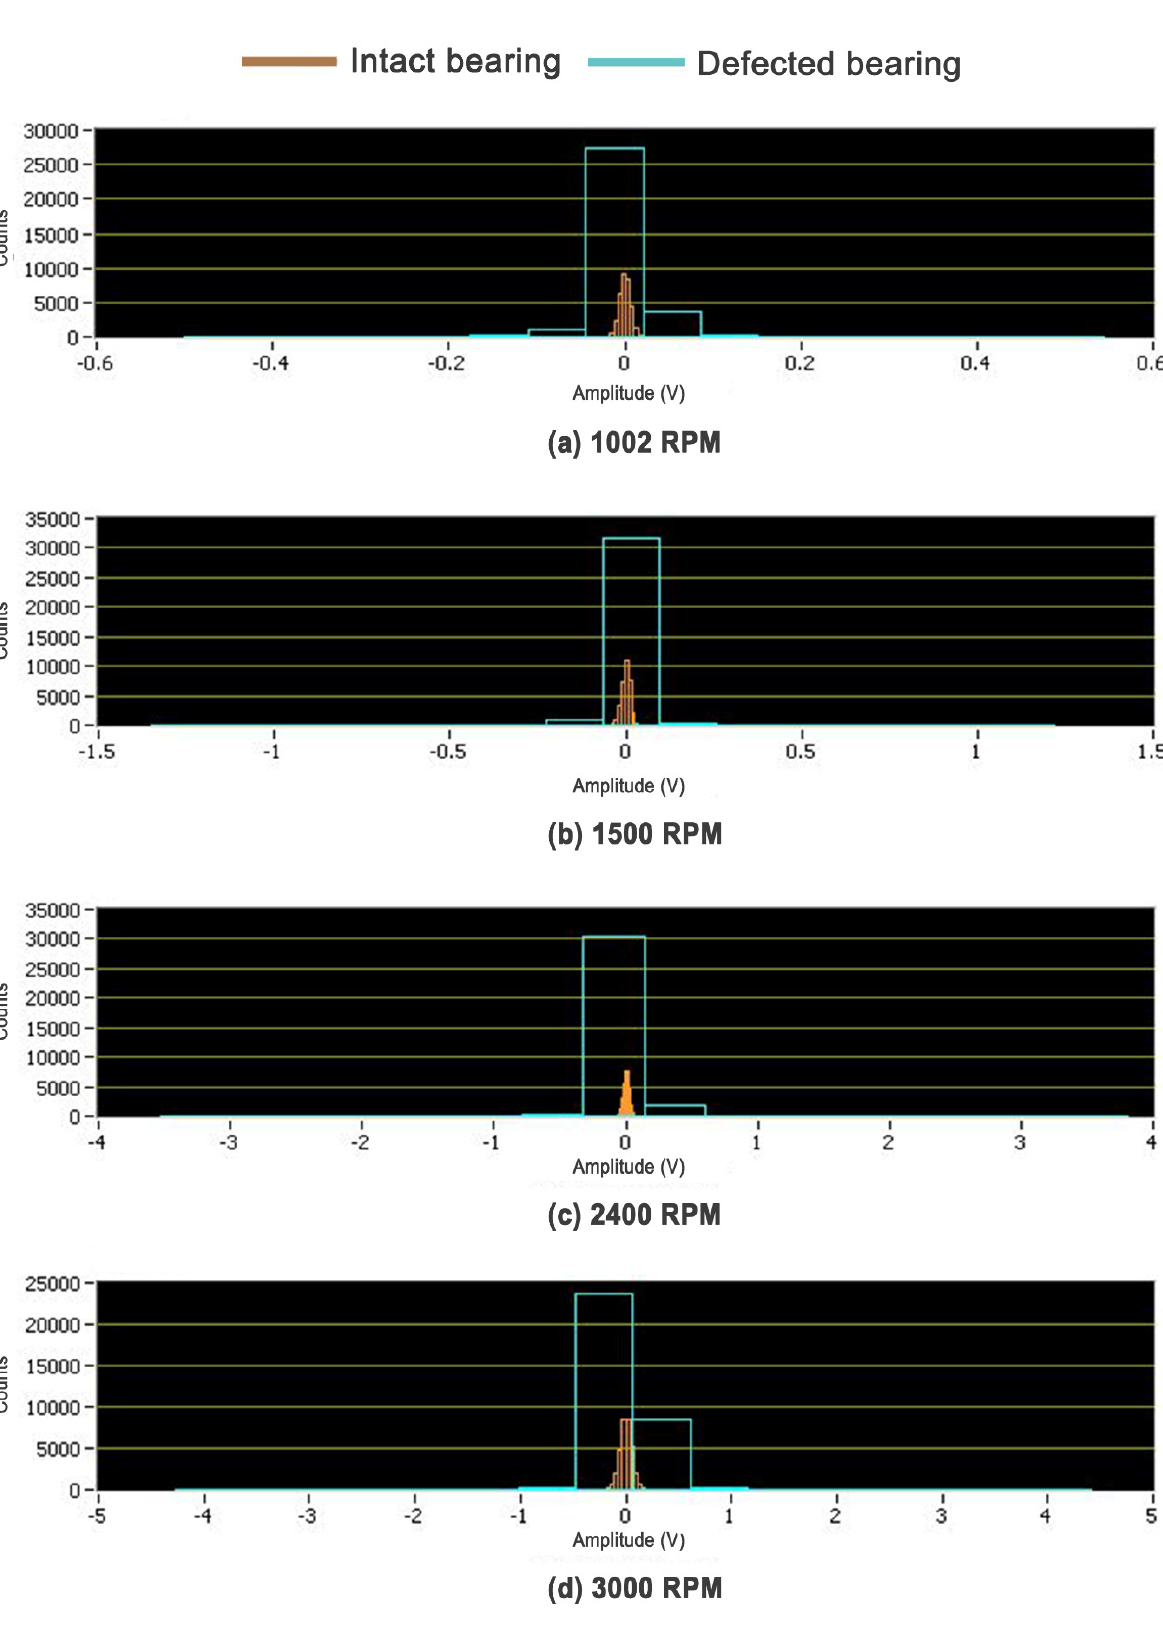
Figure 7. Histograms for ball damage with installing a bearing loader.